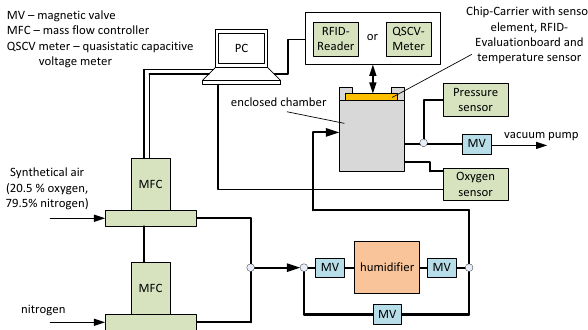
Figure 7. Simplified diagram of the test station with magnetic valves (MV) for flow path selection, mass flow controller (MFC) and sensor element with connected read-out devices via RFID and quasi-static capacitive voltage metre (QSCV).